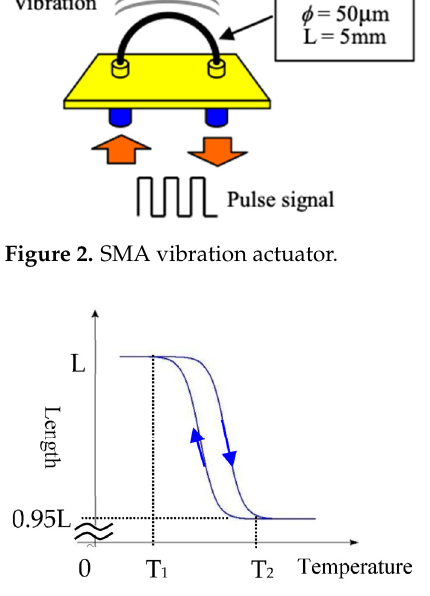
Figure 3. Temperature characteristics of SMA wire.